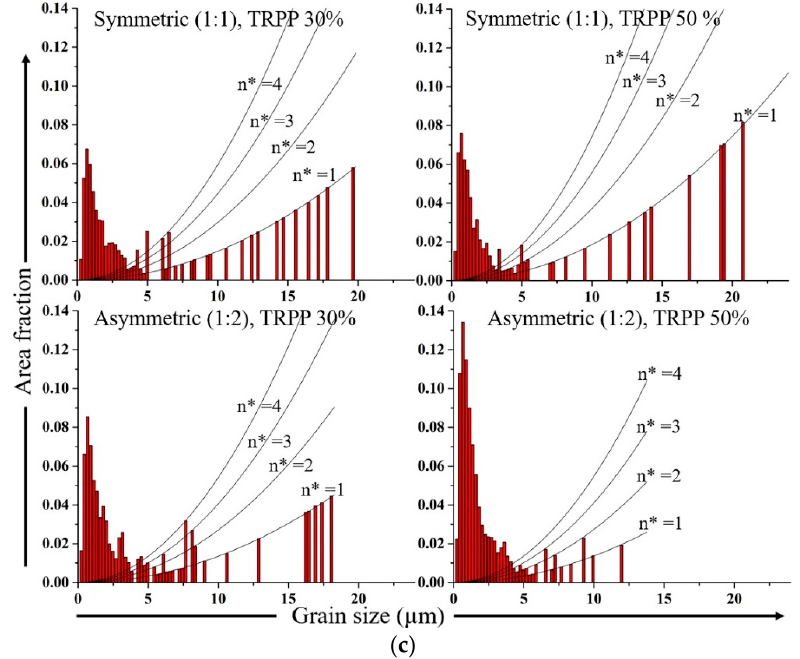
Figure 12. ( a ) Grain boundaries frequencies for symmetric and asymmetric (1:2) rolling for of 30% and 50% in high strain regime (89%); ( b ) next neighbor misorientation distributions of symmetric and asymmetric (1:2) rolling for TRPP of 30% and 50% in the high strain regime (89%); ( c ) grain size distribution (area fraction) for symmetric and asymmetric (1:2) rolling with TRPP of 30% and 50% in high strain regime (89%). The added parabolas indicate the number of large grains being in the same bins (n*).